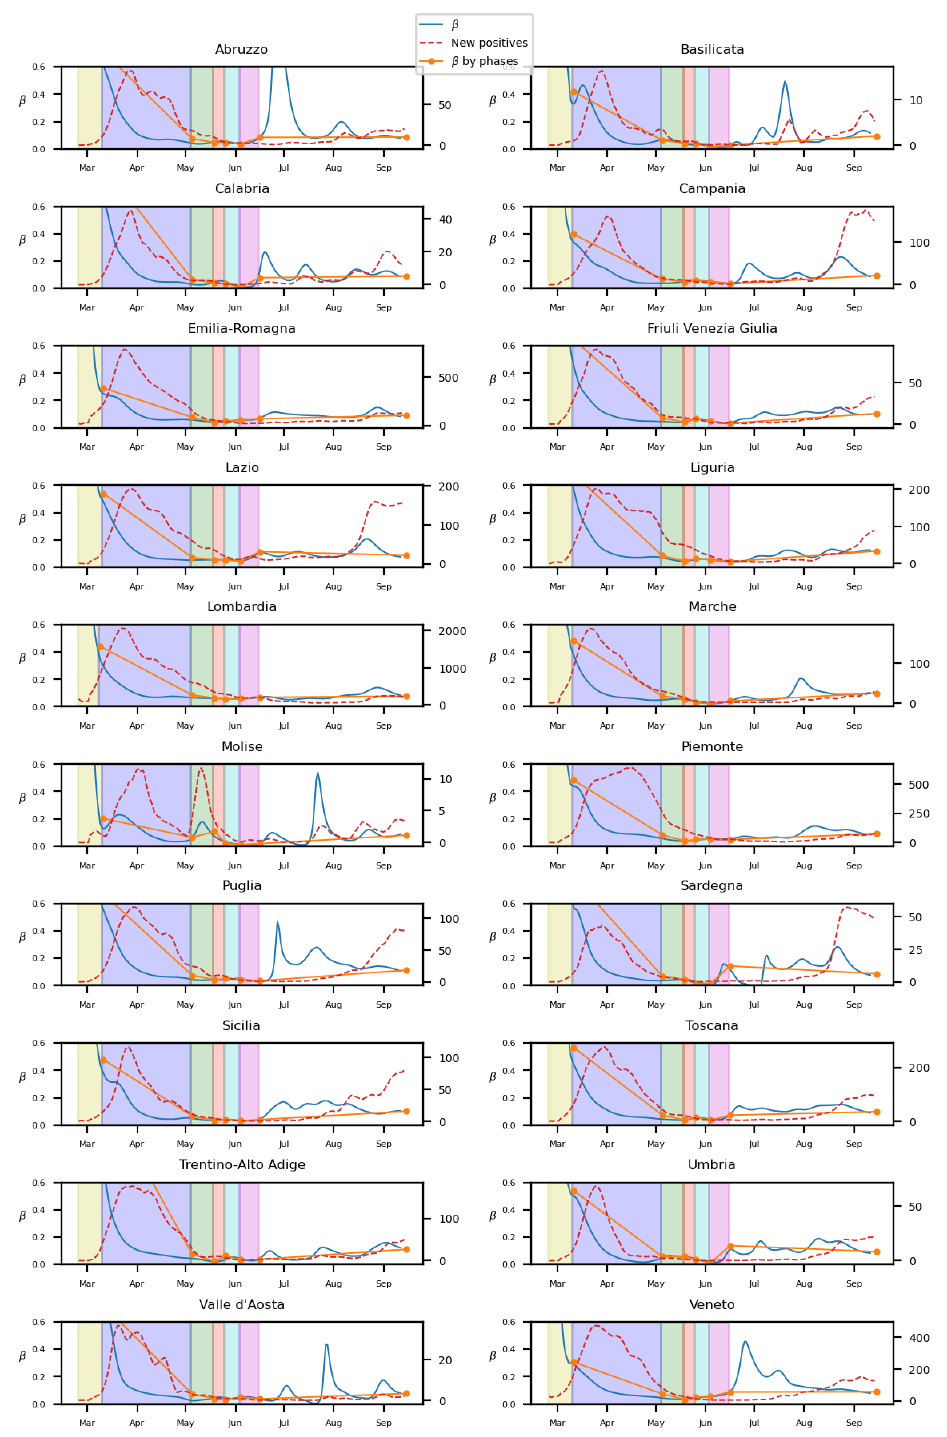
Figure 6. The y axis on the left on each subfigure correspond to the parameter β , while the one on the right to the number of new registered infectious. Each background color represents a different stage of lockdown of Italy: Lockdown, phase 1,2,3,4. White background correspond to pre-lockdown and normality. Red dotted line: The value of new infected individuals at that day. Blue thin line: A 15-days average of β at that day calculated from Equation (10). Orange thick line: A linear regression of β during each